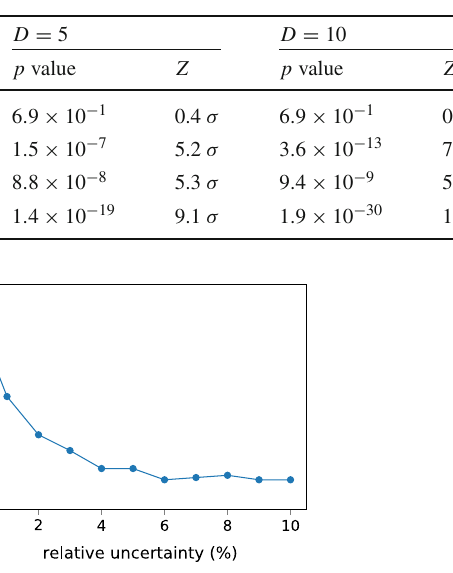
Fig. 3 We compare B = T G 0 and T = T G 3 , as defined in Table 3, with D = 2, using K = 5 and N perm = 1000. The B , T samples have the same size N B = N T . Left panel: the Z significance of the test for differ- ent sample sizes. Right panel: the Z significance for different relative